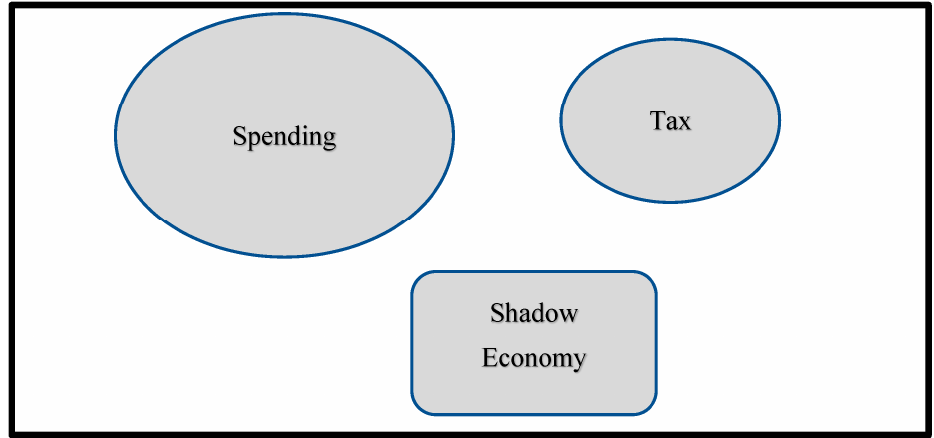
Figure 4. Government spending, taxation, and the shadow economy Source: authors’ estimations.